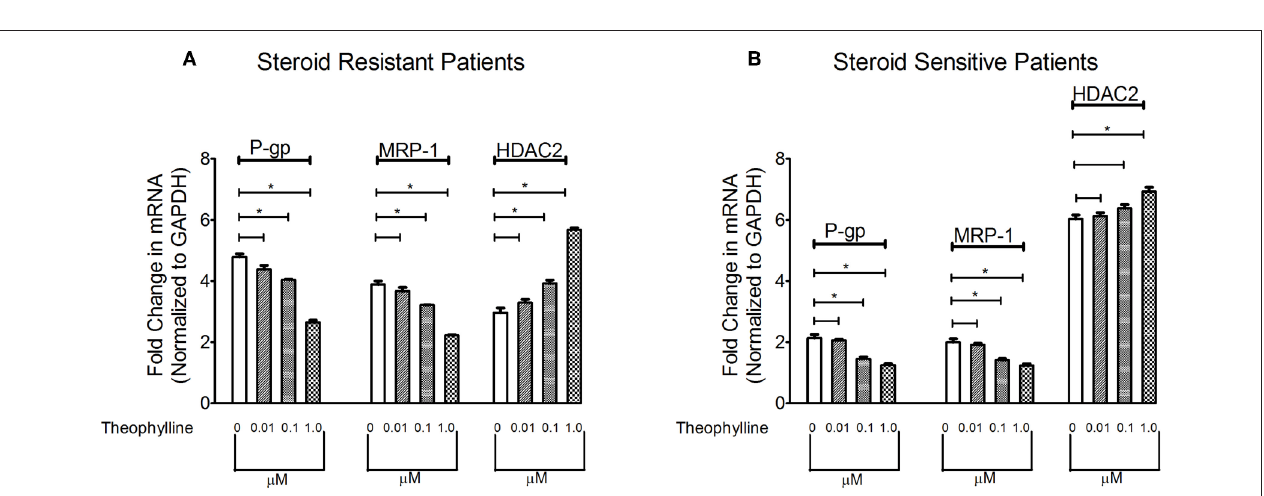
FIGURE 1 | Expression of P-gp, MRP-1 and HDAC2 on unstimulated PBMCs of SRNS and SSNS patients. Peripheral Blood Mononuclear Cells were isolated from SRNS and SSNS patients and the mRNA levels of P-gp, MRP-1 and HDAC2 were quantified by real-time PCR technique (A–C) . The experiments are representative of three independent series. Pooled data of all the experiments are represented as mean ± SEM. Significant differences compared to control were indicated by p < 0.05.